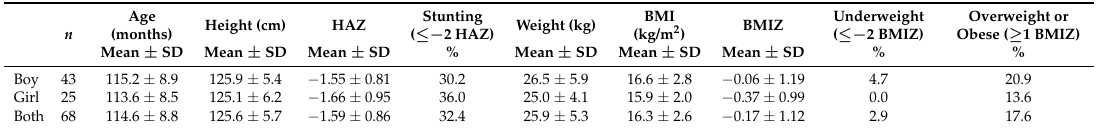
Table 1. Physical characteristics of the children at baseline. HAZ: height-for-age; BMI: body mass index; BMIZ: